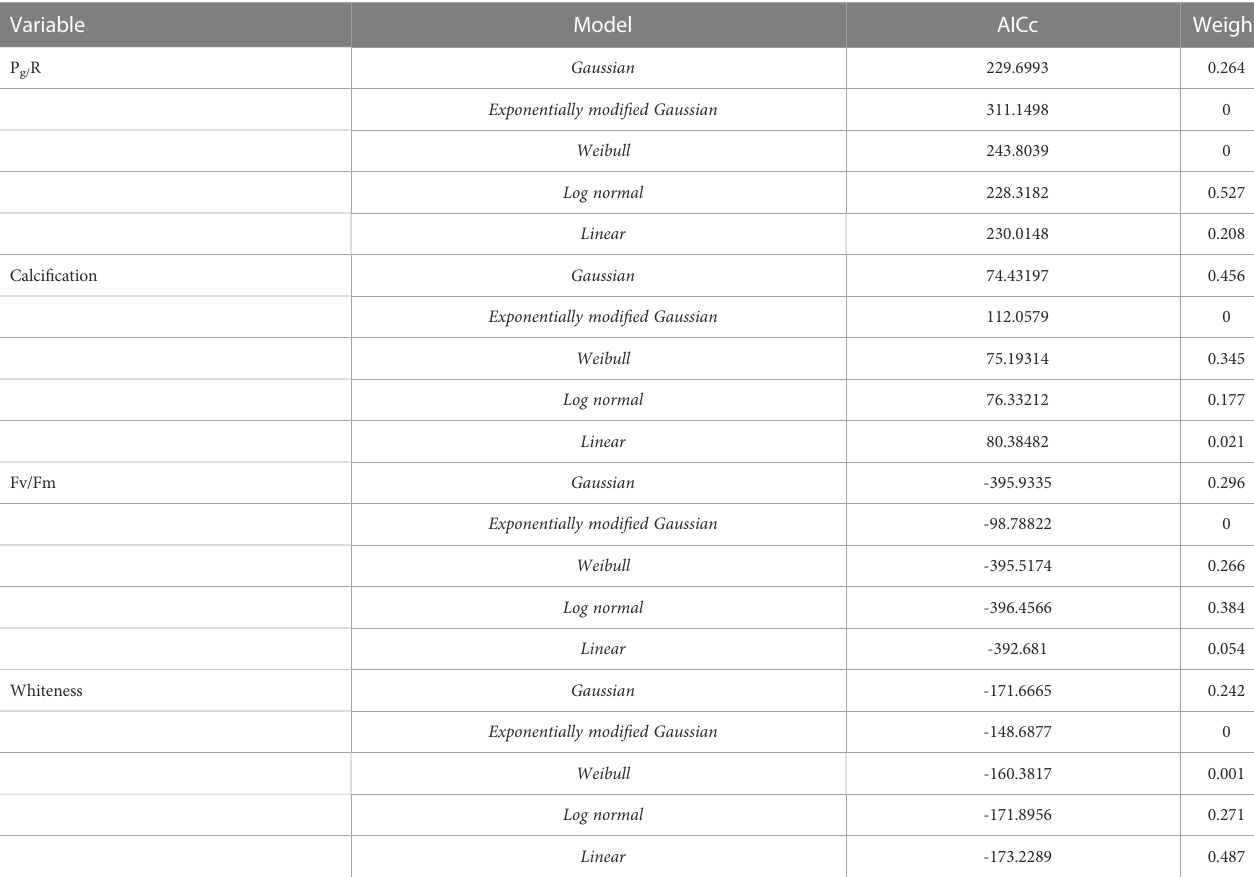
TABLE 5 Results of best- fi t models for each metabolic parameter and temperature determined using the Akaike Information Criterion (AICc).